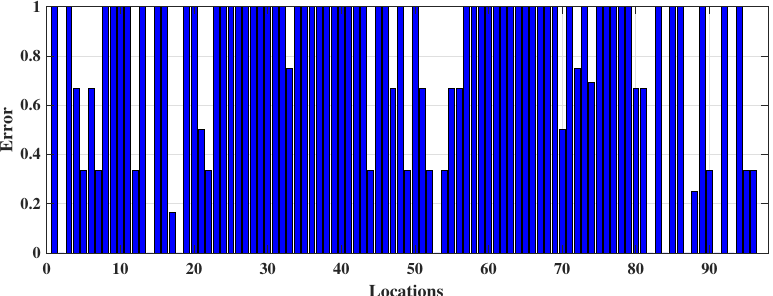
Figure 5. The occurrence of error in each coordinate from DT classification during online